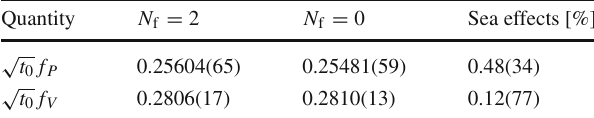
√ √ t 0 f P and t 0 f V in the continuum limit for both Table 3 Results for the N f = 2 and the N f = 0